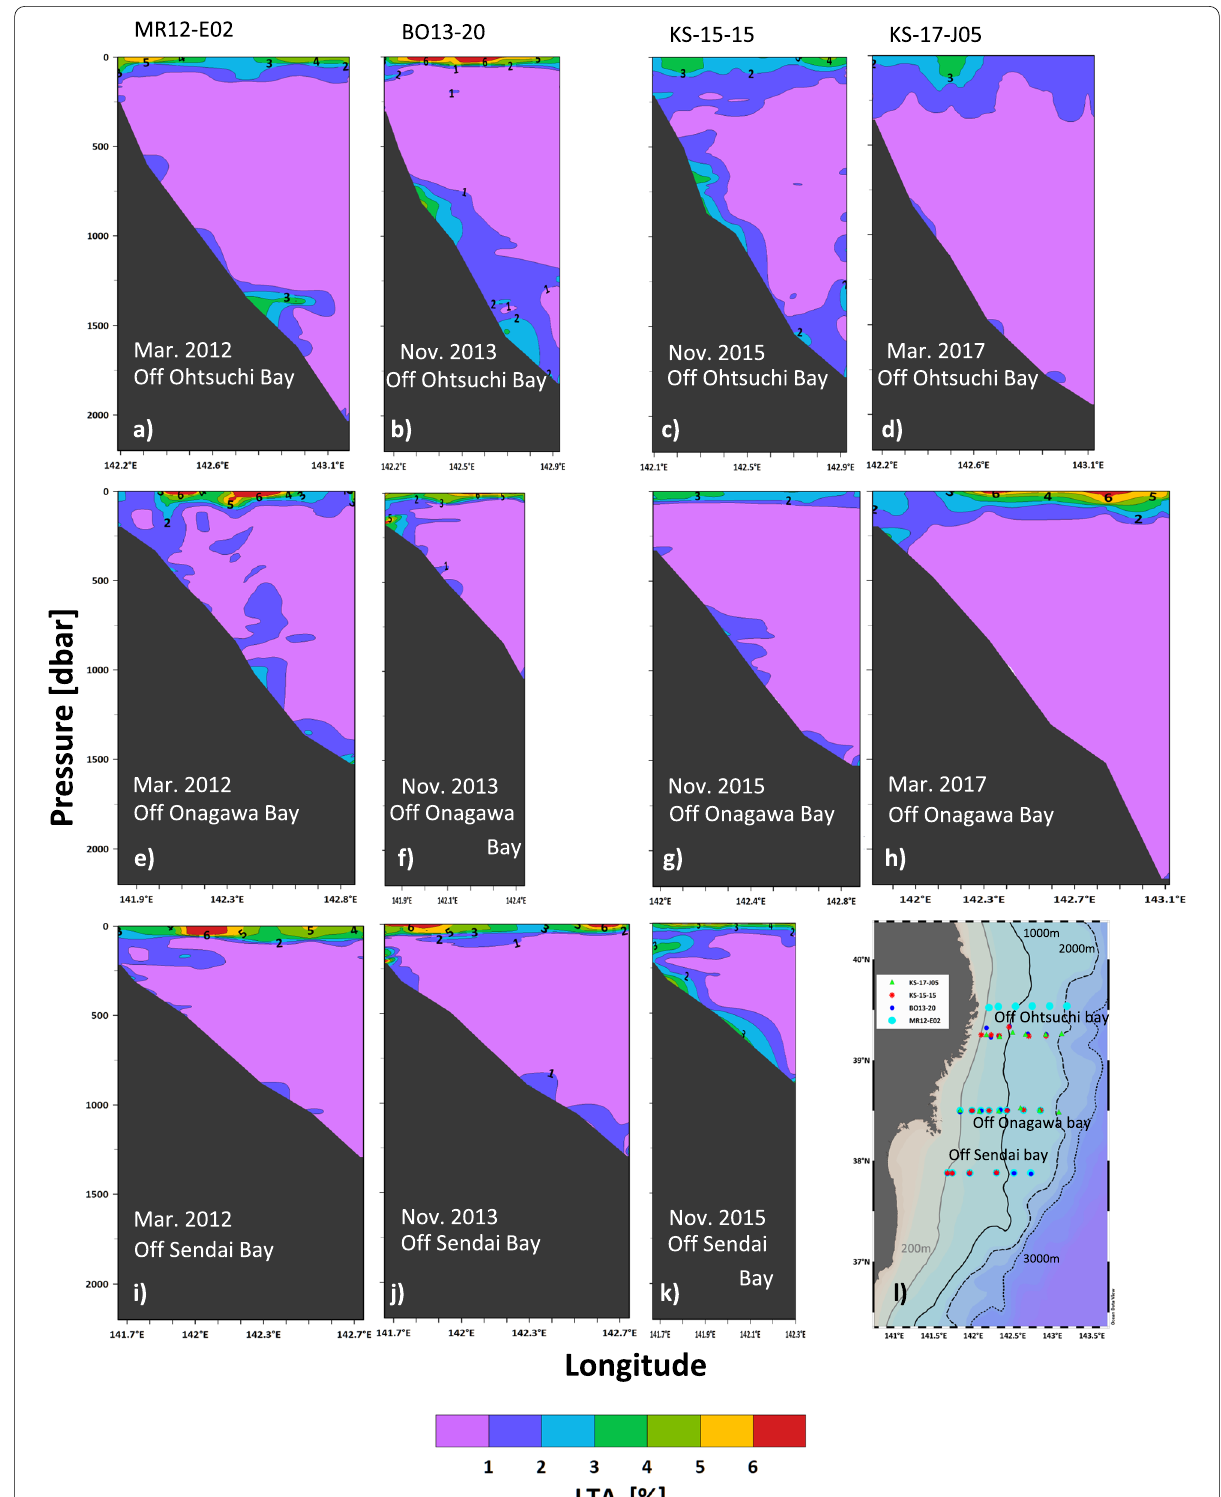
Fig. 2 Vertical distributions of light transmissometer anomaly (LTA) values measured during cruises MR12-E02 ( a , e , and i ), BO13-20 ( b , f , and j ), KS-15–15 ( c , g , and k ), and KS-17-J05 ( d and h ) off Ohtsuchi Bay, Onagawa Bay, and Sendai Bay ( l ). Contours of LTA are every